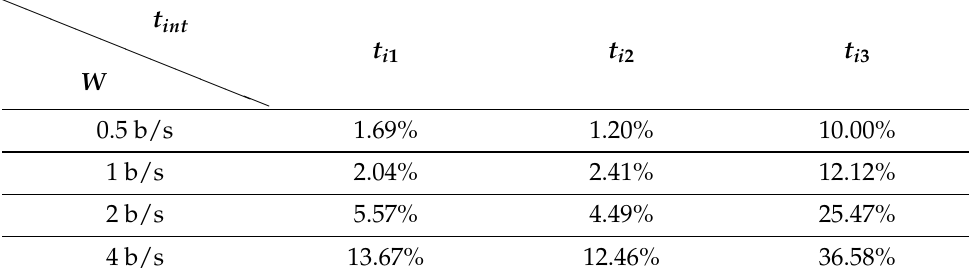
Table 2. Bit error rate determined for the amplitude variance analysis